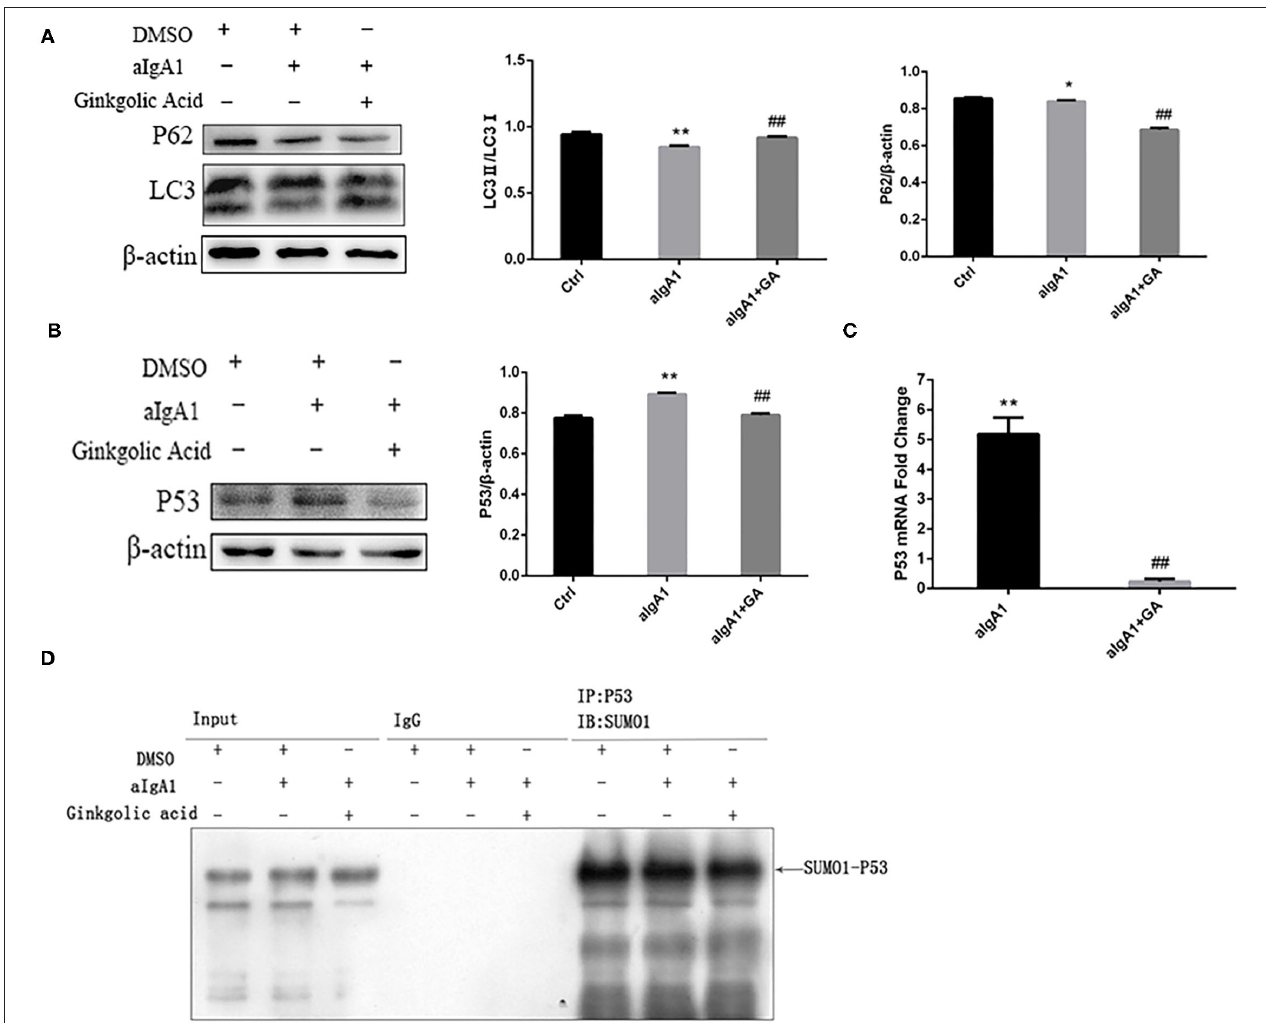
FIGURE 2 | Effects of SUMOylation inhibitors on human mesangial cells’ autophagy stimulated by aIgA1. (A,B) Western blot analysis for LC3II/I, p62, and p53 in mesangial cells. Cells were treated with aIgA1 and Ginkgolic Acid, and then the whole cells lysates were collected for western bolt analysis. (C) Real-time PCR analysis of p53 mRNA. (D) Immunoprecipitation for SUMO1-p53 in mesangial cells. Data were presented as mean ± SD ( n = 10). * p < 0.05 vs. control, ** p < 0.01 vs. control, ## p < 0.01 vs. aIgA1 group.